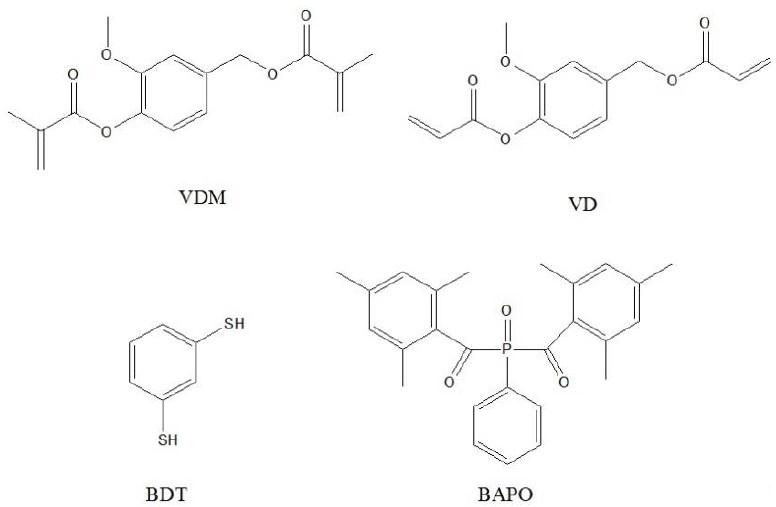
Figure 1. Structures of vanillin dimethacrylate (VDM), vanillin diacrylate (VD), 1,3-benzenedithiol (BDT), and phenylbis(2,4,6-trimethylbenzoyl)phosphine oxide